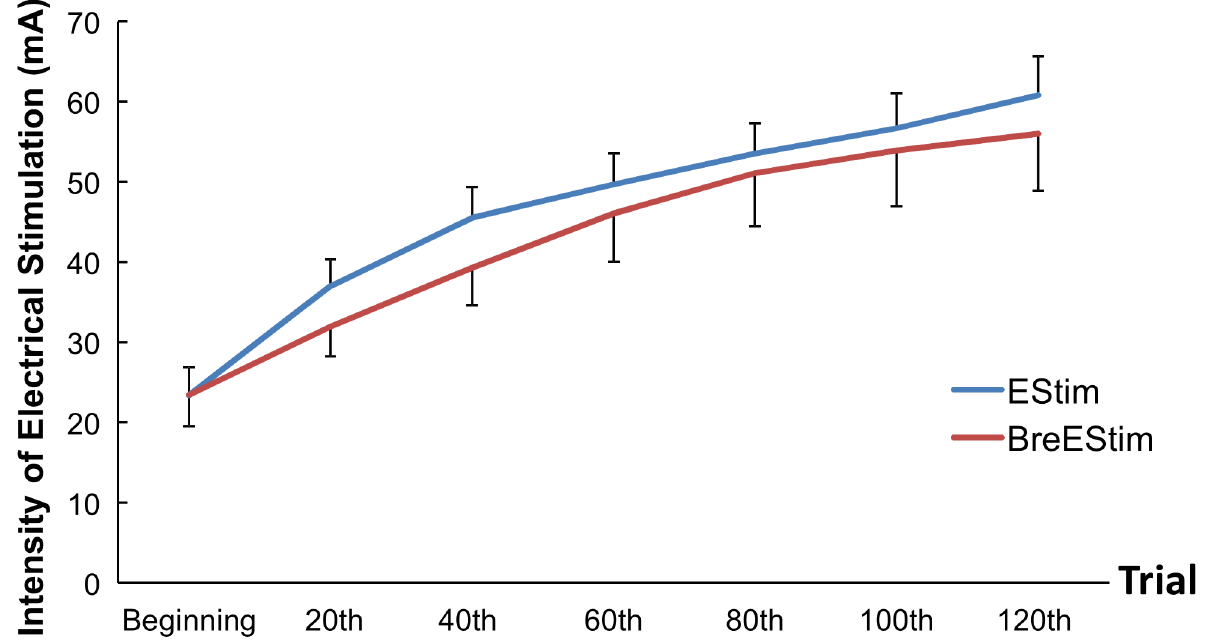
Figure 4. The intensity of electrical stimulation from beginning (trial 0) to the end (trial 120) during BreEStim and EStim. Average values and standard errors are presented.